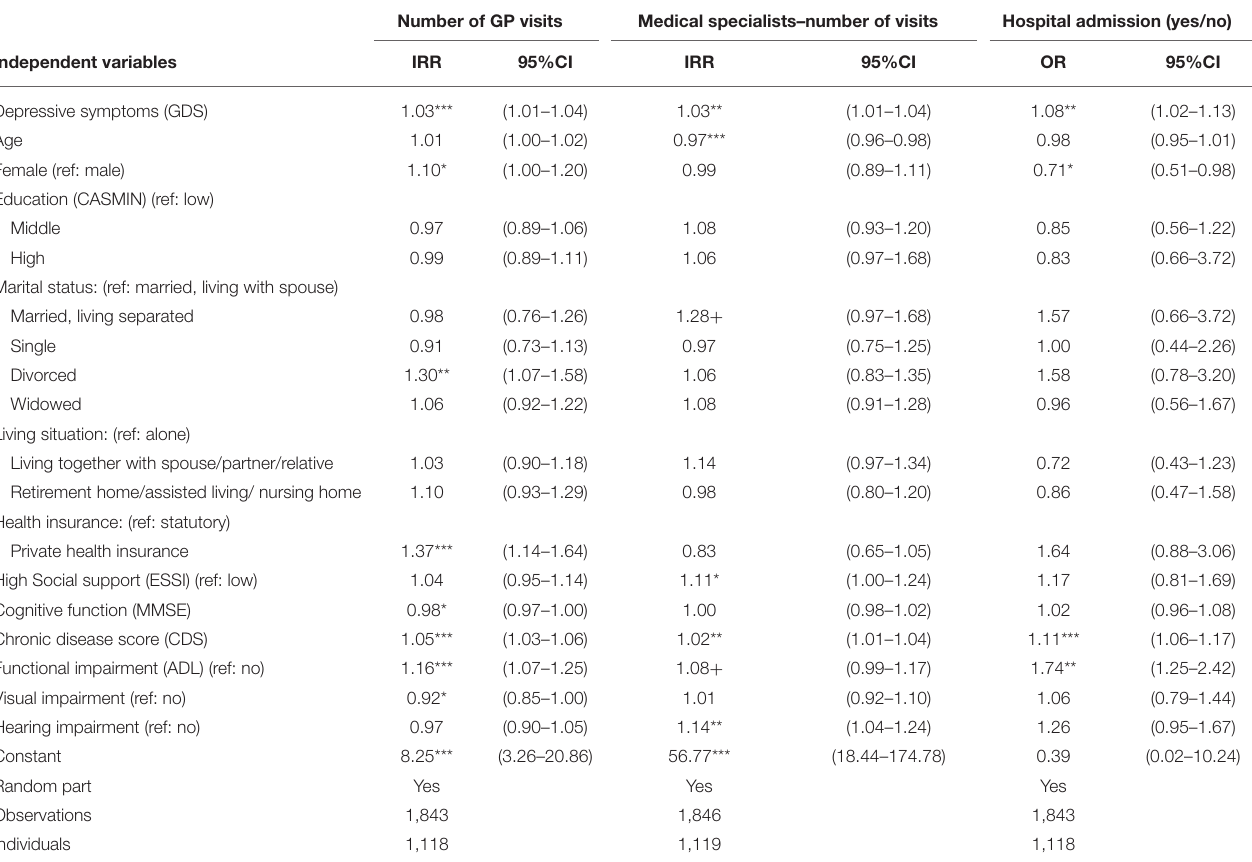
TABLE 2 | Determinants of health care utilization (GP visits, specialist visits and hospital admission) in late life among community-dwelling